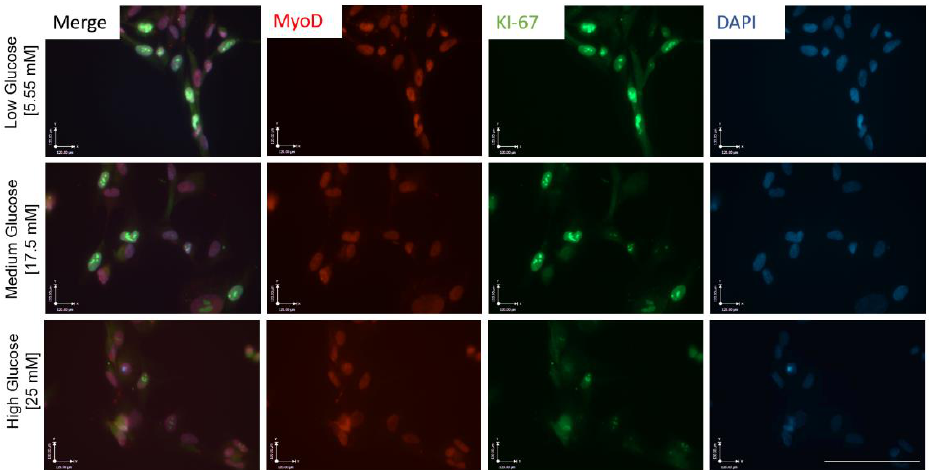
Figure 2. ICC for MyoD and KI-67 expression in iPSC-derived myoblasts cultured in medium of the three varying glucose concentrations, 5 days in vitro. Scale bar = 50 µm.